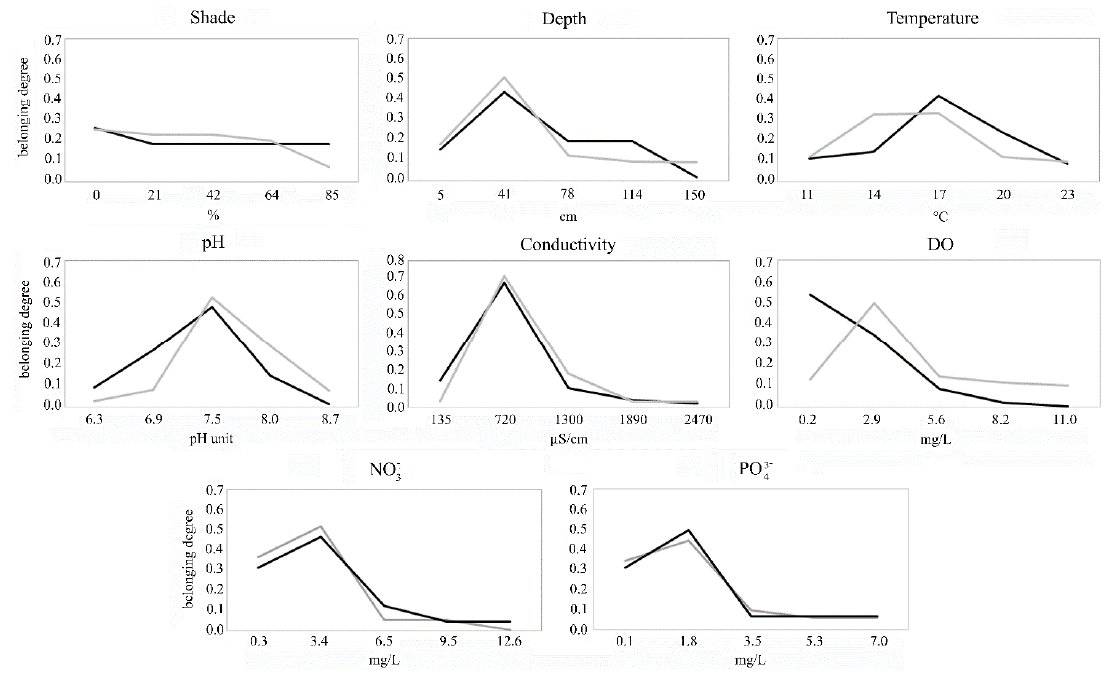
Figure 3. Ecological response curves of L. minuta (dark grey line) and C. lemnata (light grey line) populations to each environmental variable.